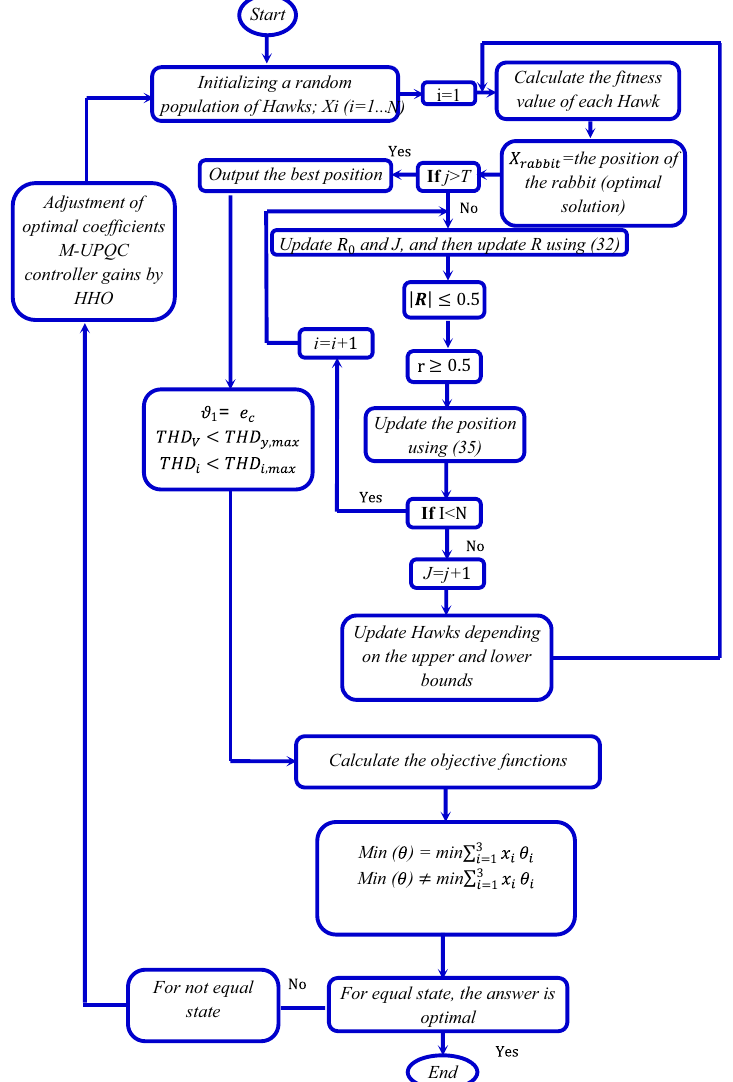
Figure 8. Flowchart of the proposed technique based on HHO